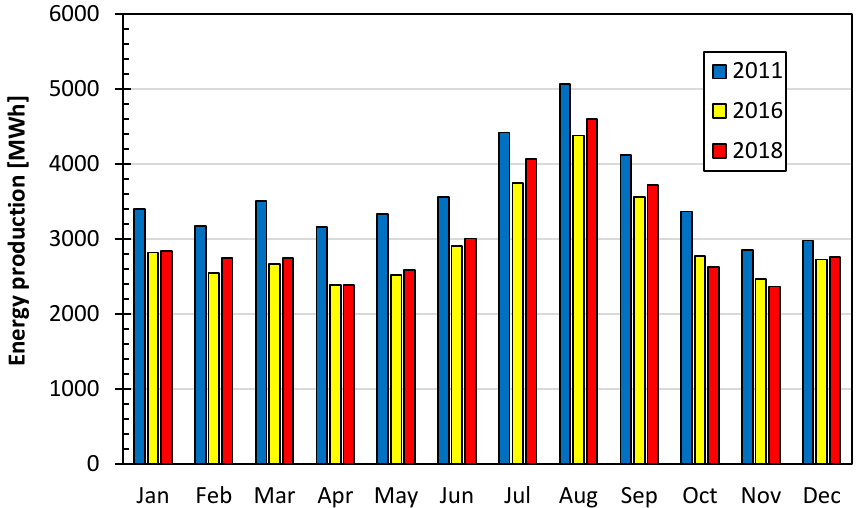
Figure A3. Comparison of monthly electricity production in 2011, 2016, and 2018 [87,80].